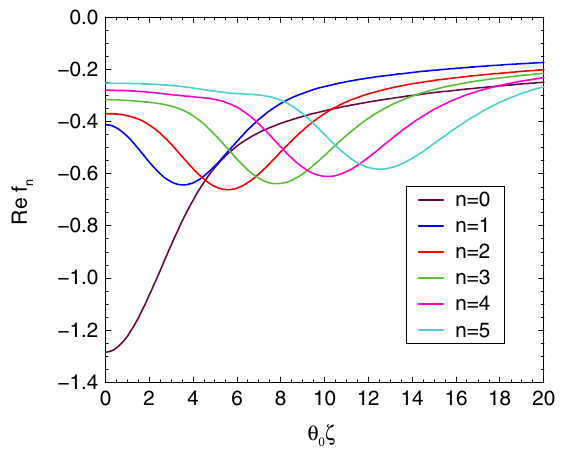
FIG. 8. Normalized eigenfunctions of Gaussian bunch trun- cated on the 3 (cid:15) level (0th–5th modes). Related reduced eigen- are given in the parentheses. The black curve numbers (cid:8) n represents the bunch lineal density (unnormalized).